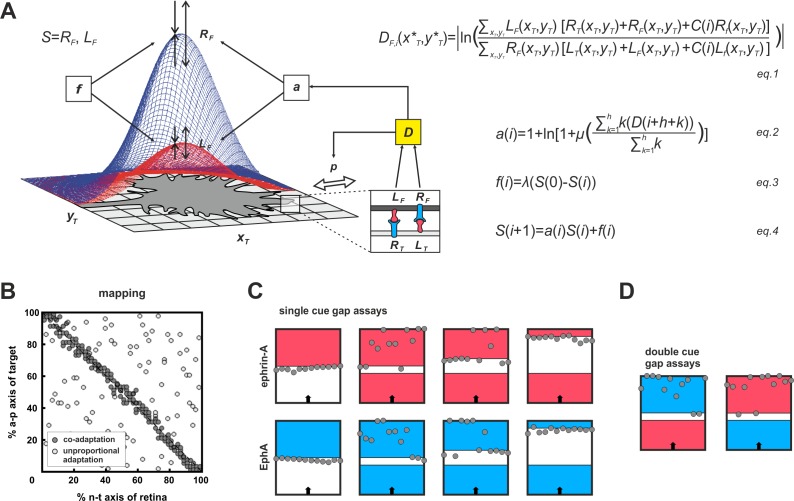
Modeling growth cone adaptation and topographic mapping.(A) Fiber terminals are modeled as circular discs bearing Gaussian-shaped distributions of EphAs (RF, blue) and ephrin-As (LF, red), according to their retinal origin, moving on a rectangular target field of unit squares (xT, yT), carrying target-derived guidance cues (LT and RT). Fiber–target and fiber–fiber (cis and trans) interactions and the resulting forward and reverse signals integrate into a guidance potential, D (equation1), which determines the probability, p, of a change in position (only fiber–target interactions are illustrated in the inset). Additionally, D is used to calculate an adaptation coefficient, a (equation2), which simultaneously modulates RF and LF (collectively called S; equation4) through 'co-adaptation'. A resetting force, f (equation3), counteracts a. For mathematical detail see 'Material and methods'. (B) Mapping plots of simulations with 200 fiber terminals using different implementations of adaptation. The anterior-posterior (a-p) position of a terminal on the target is plotted as a function of naso-temporal (n-t) origin (perfect topography is indicated by all terminals targeting the main diagonal). Terminals that are enabled to regulate sensors independently from each other by canonical adaptation are widely scattered across the target field (white circles), whereas co-adapted terminals (regulating both sensors concomitantly) find their topographically correct target positions (gray circles). In the basic model, the potential minimum is at a position where fiber and target ephrin/Eph concentrations match. Therefore, canonical adaptation was implemented in terms of a tendency for GCs to independently match their forward and reverse sensor levels to the receptor and ligand levels, respectively, on the current target position. (C) After implementation of co-adaptation, naïve terminals stop in front of a field of high ephrin-A or EphA (LT = 4, red; RT = 4, blue), respectively, but ignore the same boundary in simulated gap assays with small gap size. In simulations with wider gaps, terminals stop again in front of the second field. Gap size = 20, 40, or 100 units respectively; n = 12; i = 2000; target field: 200 × 8. (D) Co-adaptation predicts that ephrin-A adapted terminals will ignore a field of high EphA after a small gap and vice versa. Gap size = 20; other parameters as in (C).